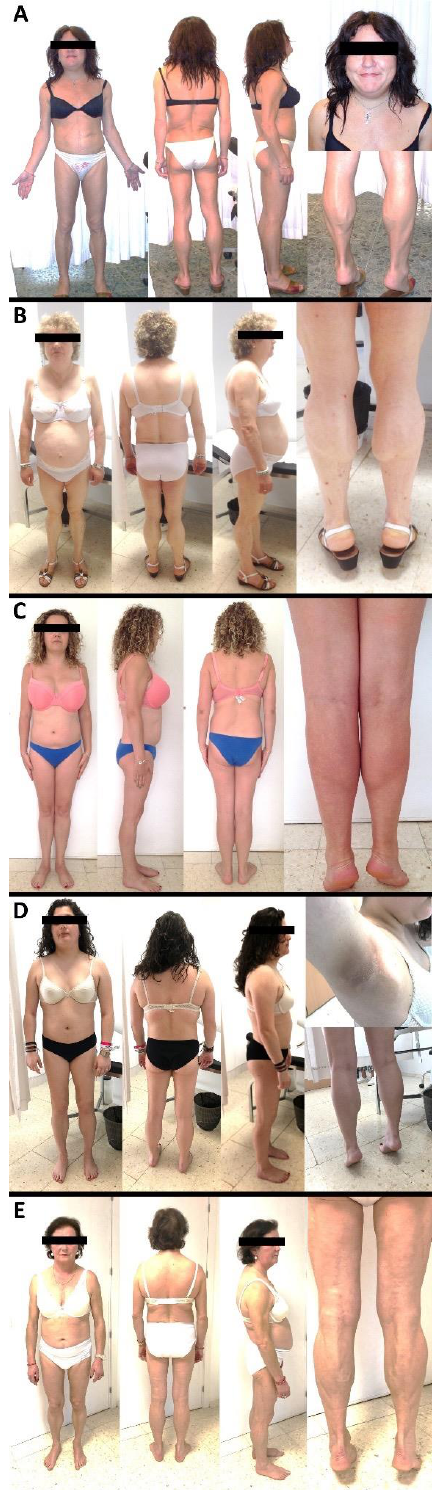
Figure 1. Photographs of the five cases with FPLD2 bearing the p.(Thr528Met) variant in the LMNA gene. The photographs show body morphology caused by the p.(Thr528Met) variant. ( A ) Case #1 is a 53-year-old female. Fat loss higher than in the other patients. Lack of subcutaneous adipose tissue in limbs, abdomen and buttocks. Rounded face, double chin, hypermuscular appearance with calf hypertrophy, hepatomegaly, phlebomegaly and small breasts. ( B ) Case #2 is a 58-year-old female. Fat loss in upper limbs, hips, thighs and calves. Fat accumulation in face with double chin, in upper back and intra-abdominal region. Scarce abdominal subcutaneous adipose panicle. Phlebomegaly.